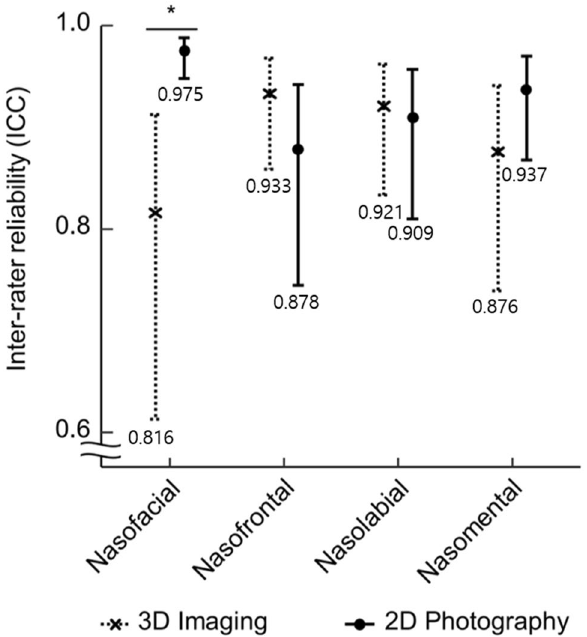
Figure 4. Comparison of inter-rater reliability on 3D imaging and 2D photograph (crosses and dots represented ICC, error bars represented 95% CI) showed that inter-rater reliability had significant difference for nasofacial angle while other angular parameters had no statistically significant difference between the two techniques (* p < 0.001). The value under error bars represented ICC